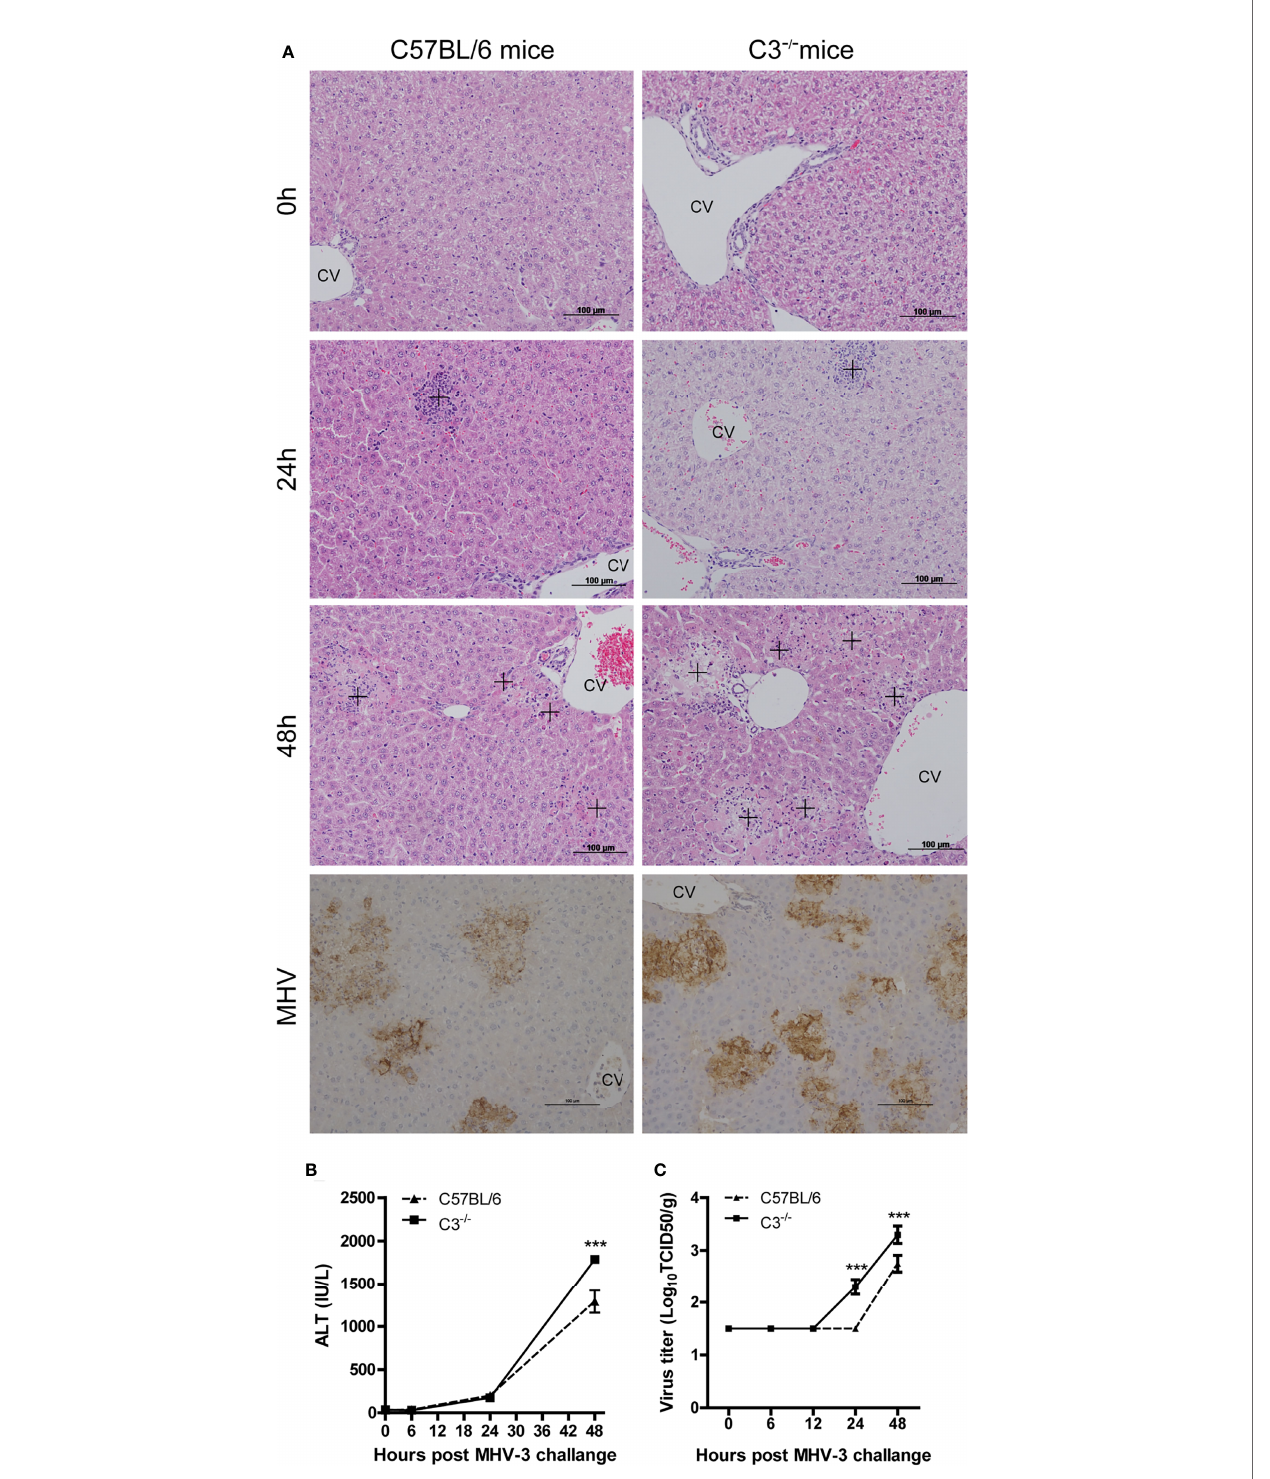
FIGURE 2 | Severe liver damage in C3-de fi cient mice after MHV-3 infection. WT and C3-/- mice were euthanized 0, 6, 12, 24, and 48 hrs after MHV-3 challenge. (A) Histological examination of liver tissue of mice at the indicated times and immunohistochemical staining for viral antigen in liver samples 48 hrs after virus challenge (cross, in fl ammatory in fi ltrats area in 24hrs and necrotic area in 48hrs). (B) Serum ALT concentrations at the indicated times. (C) Virus titer in livers at the indicated times. These results are representative of three independent experiments with similar results (n = 4 – 5 per group). *** p <0.001 compared with WT control. Original magni fi cation,